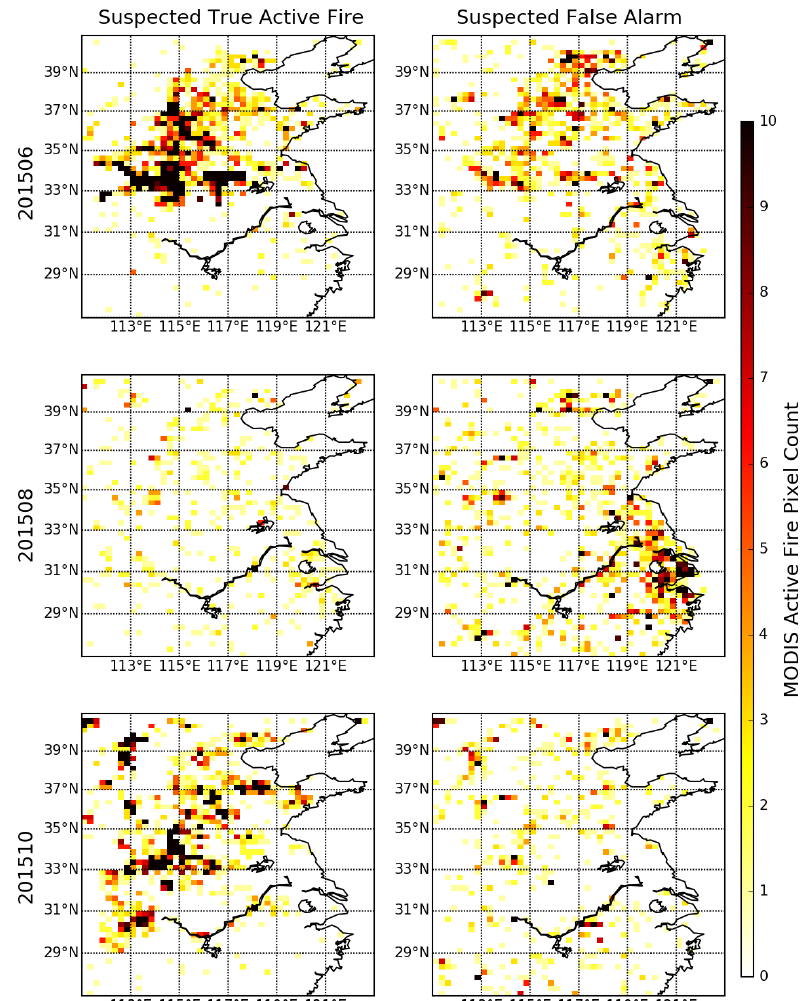
Figure 4. MODIS active fire (AF) pixel counts from MCD14 (0.25 ° grid cell resolution) in the eastern China region highlighted by the blue dashed box in Figure 1. AFs were classified via the landcover-based approach of Zhang et al. [17] as either suspected “true” active fire detections (left column), or false alarms (right column). The latter are identified by their occurrence in non-vegetated areas, such as urban regions (see [17] for more details). The ‘true’ and ‘false alarm’ AF counts are shown for June (upper row), August (middle row) and October 2015 (lower row), and false alarm AFs are clearly most apparent in August 2015 and in the region of eastern China highlighted in Figure 1f as showing a potentially suspicious region of very significantly ‘boosted’ GFED4.1s burned area.